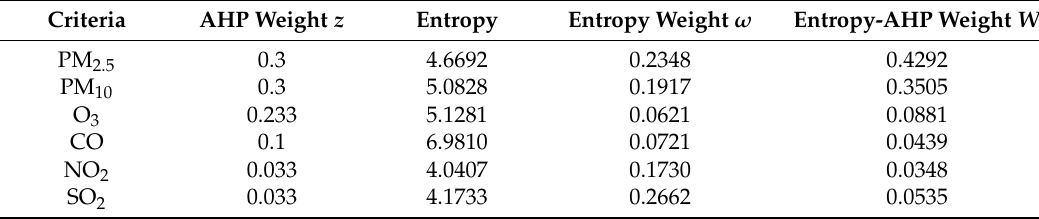
Table 12. AHP-entropy weights for all criteria.